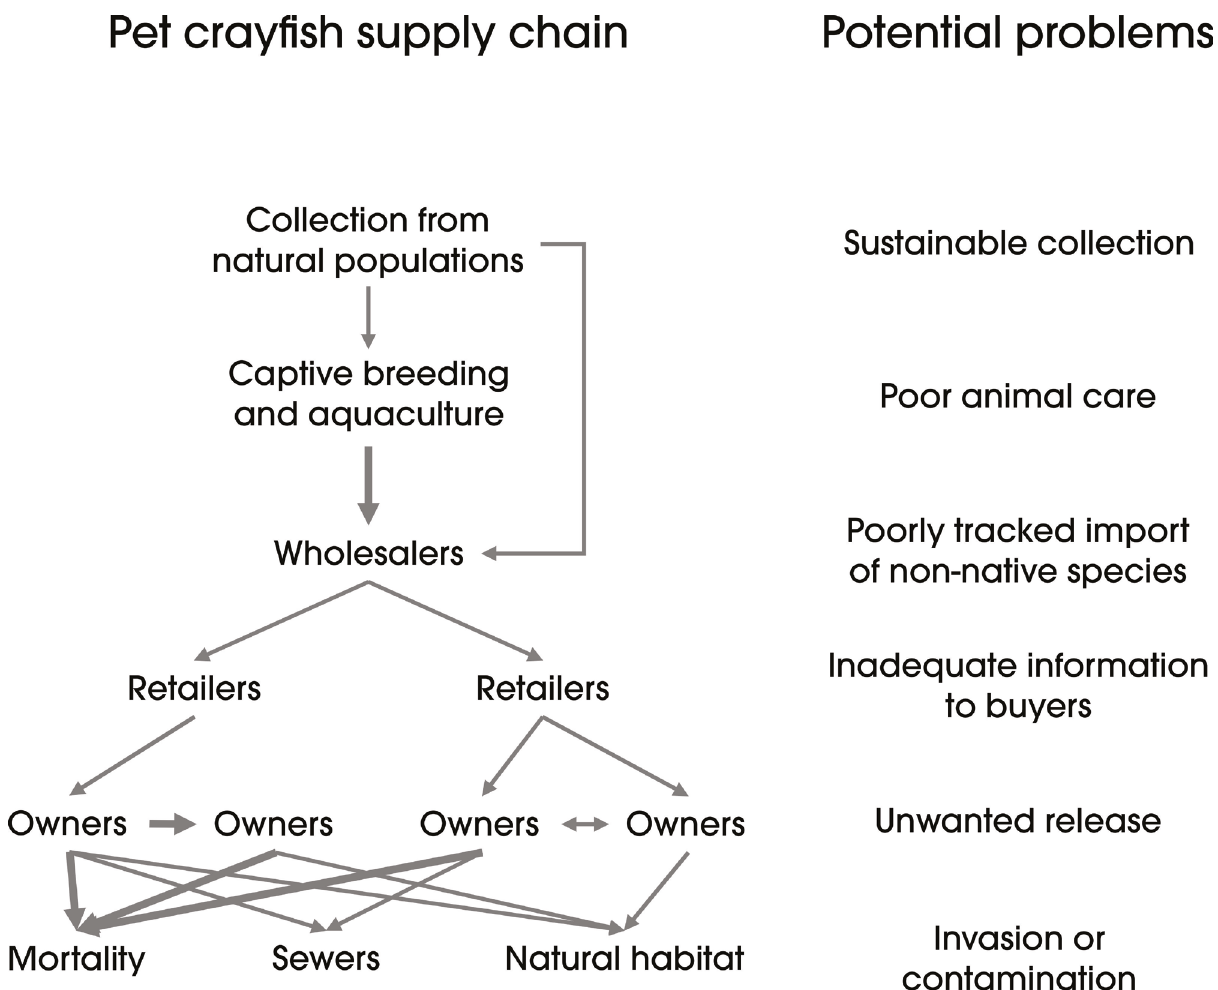
Figure 1. Supply chain of ornamental species in the pet trade. Any species sold in the aquarium trade is initially taken from wild populations (Ng and Tan 1997; Raghavan et al ., 2013), although aquaculture can replace collection from the wild as a supply for the pet trade (Ng and Tan 1997; Voigt, 2016). Most freshwater aquarium fish species are aquacultured (Whittington and Chong, 2007; Maceda-Veiga et al ., 2016), although the proportion for crayfish species that are aquacultured is unknown. Breeders and wholesalers may be one and the same entities. These are unlikely, however, to deal directly with the members of the public who buy and own pets. Retailers are the main source of animals for sale to the public, although owners may share or sell pets directly among themselves (Faulkes, 2015b). Aquatic pets often die in captivity, but those that do not may be released alive either into sewer systems (Assis et al ., 2014; Patoka et al ., 2014; Blanchette, 2016), where probability of survival is low, or into outdoor habitats (Chucholl, 2013; Pârvulescu et al ., 2017), where they may become unwanted introduced species. Even when crayfish die in captivity or soon after release, they can still spread diseases post mortem, such as crayfish plague (Oidtmann et al ., 2002) if their bodies contact natural